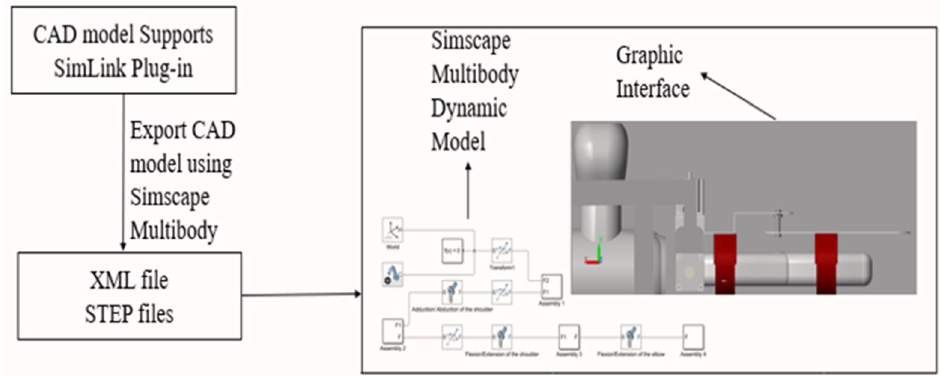
Figure 6. A block diagram that describes how the physical model was generated in MATLAB–Simulink from the original CAD file.